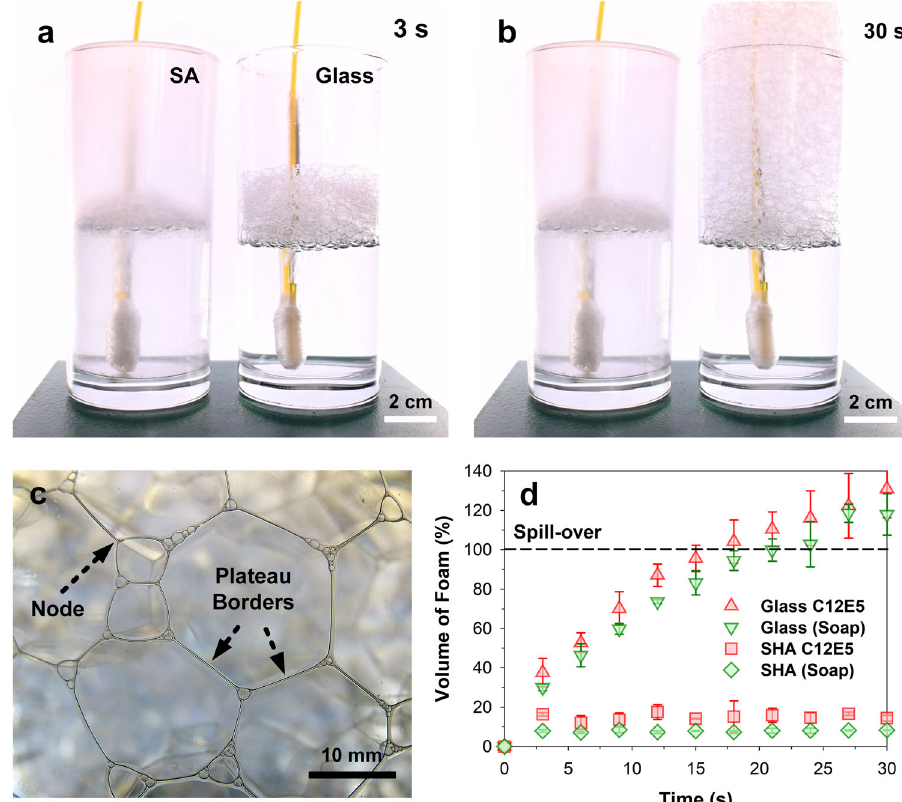
Fig. 6 Demonstration of antifoaming and froth control. Antifoaming was quanti fi ed using a bubbling setup that delivers ca . 5 mL s − 1 of nitrogen at 0.25 bars through a U-tube at an inner ori fi ce diameter of 0.5 mm. The soap demonstrated here was ( a , b ) pentaethylene glycol monododecyl ether (C12E5, critical micelle concentration of 0.03 g L − 1 ). The soap was mixed into water at a concentration of 0.4 g L − 1 . c Photo of foam bubble close